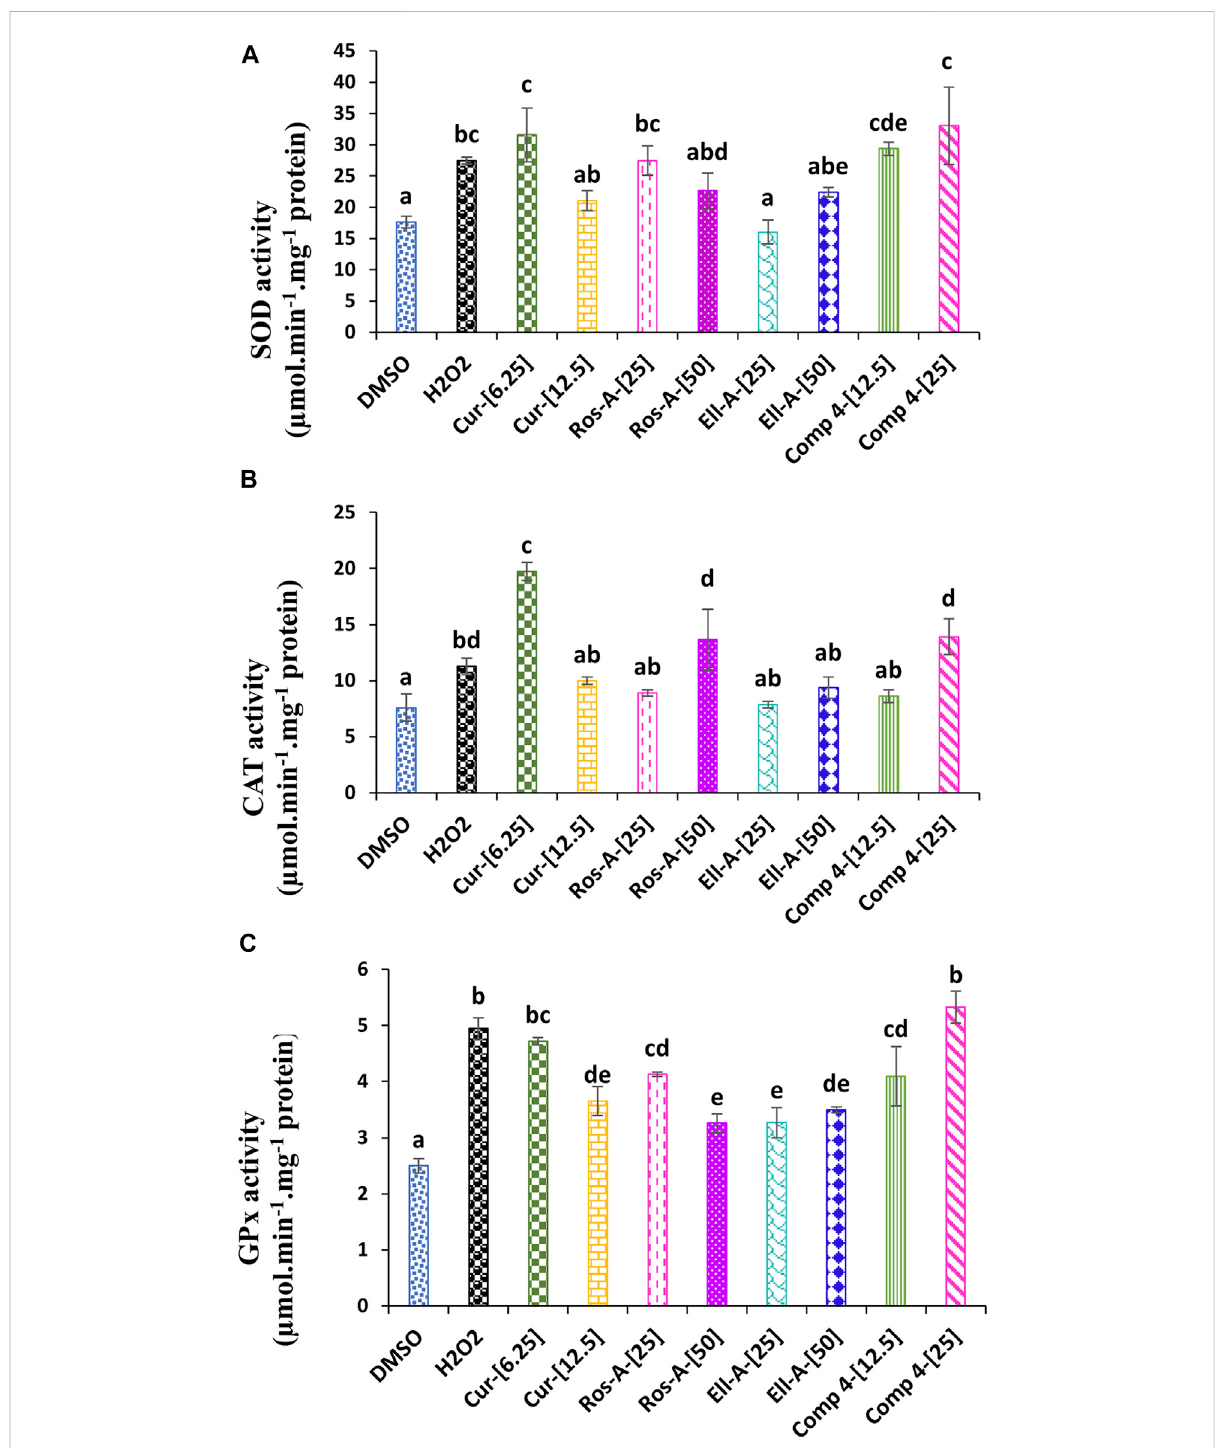
FIGURE 3 Effect of Cur, Ros-A, Ella-A and Comp-4, in THP-1 cells treated with H 2 O 2 , on (A) superoxide dismutase (SOD) activity, on (B) Catalase (CAT) activity, and (C) glutathione peroxidase (GPx) activity. Each value represents the mean of three replicate. Bars represent standard error. Different letters indicate signi fi cant differences among treatment at p <